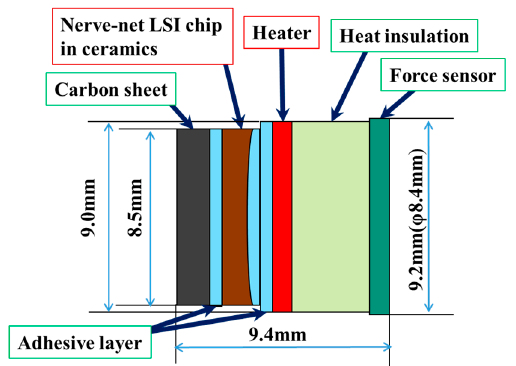
Figure 4. Structure of stacked sensor head.